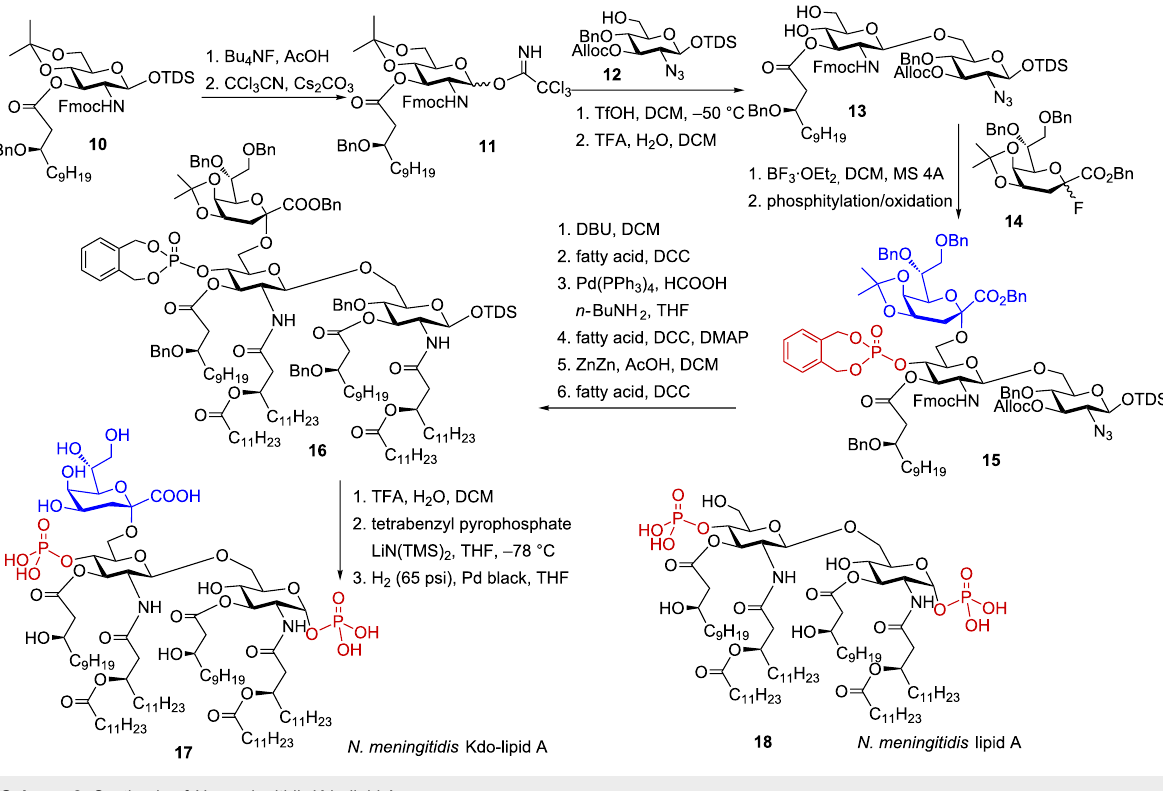
Scheme 2: Synthesis of N. meningitidis Kdo-lipid